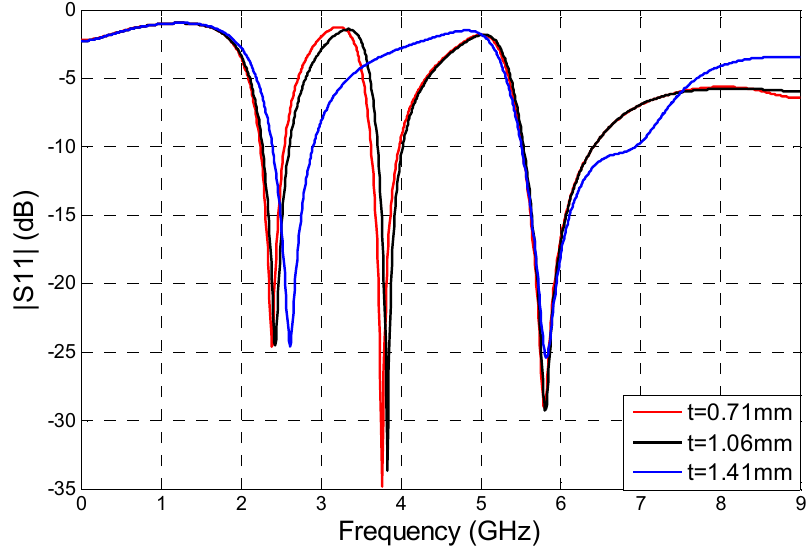
Figure 7. The effect of SRR width on the reflection coefficient of the proposed antenna.